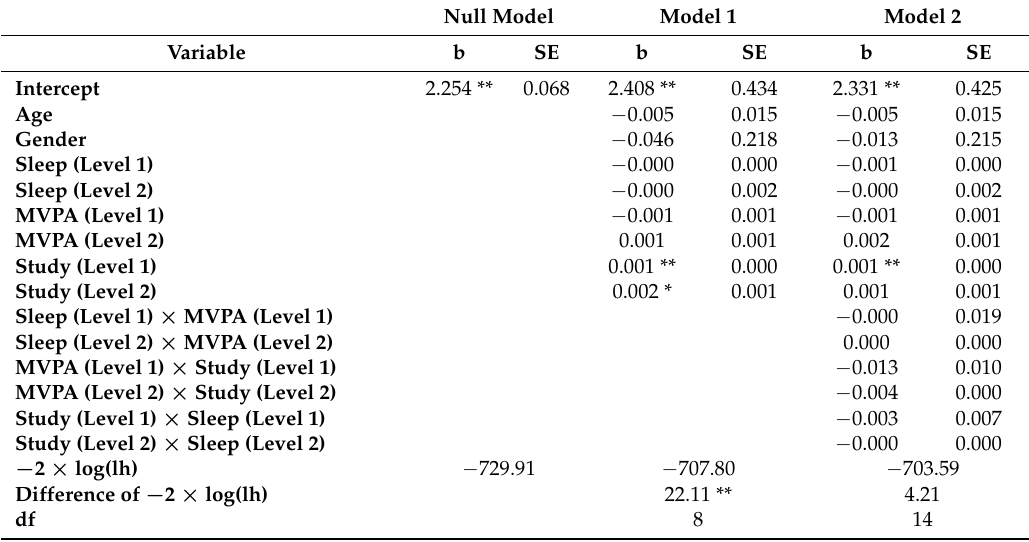
Table 4. Multilevel estimates for models predicting day-level emotional